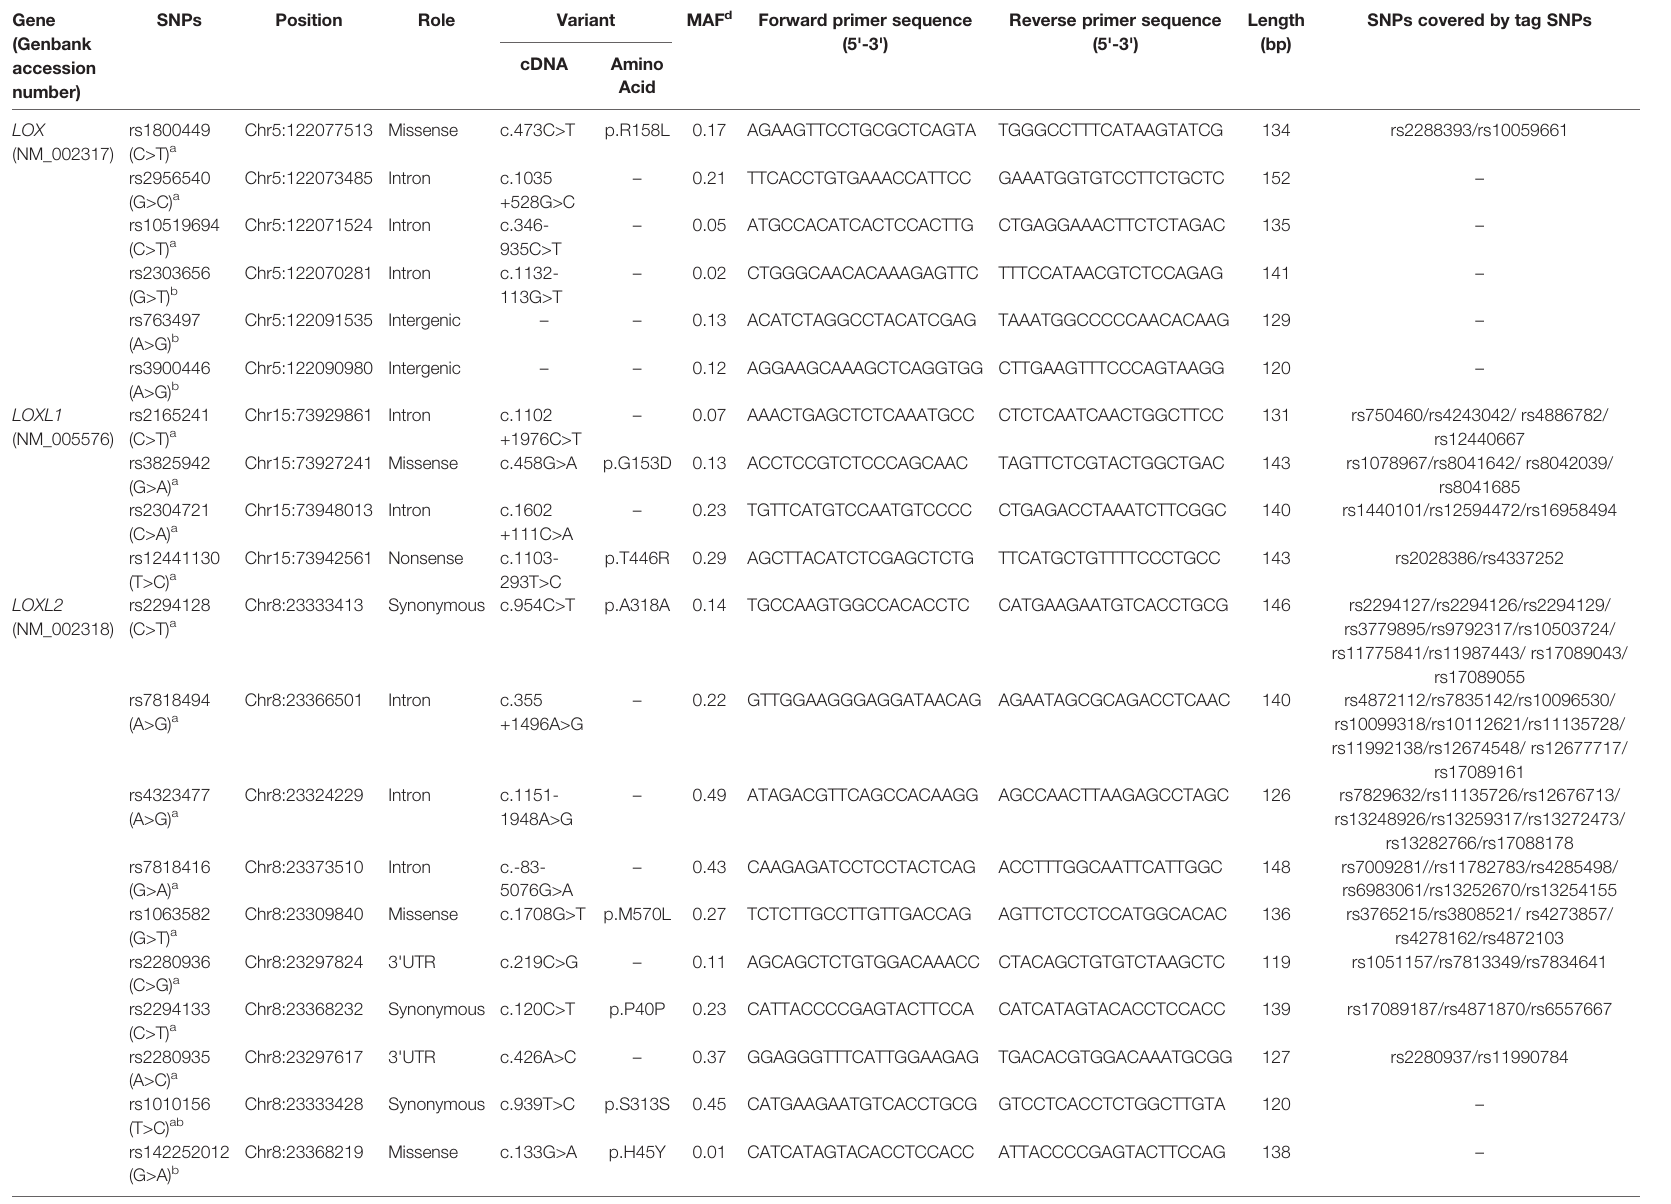
TABLE 1 | Information of LOX family genes